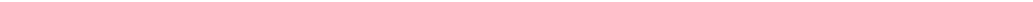
(see fi gure on previous page) Fig. 3 PNO1 inhibits cell apoptosis by promoting autophagy. A Autophagy was evaluated using TEM in Hep3B sh-Ctrl and sh-PNO1 cells. The arrows indicate autophagosomes or autolysosomes. Scale bar = 5 μ m (upper) or Scale bar = 1 μ m (lower). B Hep3B sh-Ctrl, Hep3B sh-PNO1, HLE Vector, and HLE PNO1 cells were immunostained with antibodies against LC3B. Scale bar: 50 μ m. C Western blotting analysis of autophagy-related protein level. D , E Quanti fi cation of relative protein expression. F – H Hep3B sh-Ctrl, Hep3B sh-PNO1, HLE Vector, and HLE PNO1 cells transfected with GFP-mRFP-LC3 lentivirus. Hep3B sh-PNO1 and HLE PNO1 cells were pretreated with rapamycin and 3-MA, respectively. Images were then acquired by fl uorescence microscopy ( F ) and the average number of yellow dots (autophagosomes) or red-only dots (autolysosomes) in the merged images per cell was quanti fi ed ( G , H ). Scale bar: 5 μ m. I – K Apoptotic rate was measured using annexin V/PI double staining in cells as in ( F ). L , M CCK-8 assay assessed the viability of cells as in ( F ). N Western blotting analysis of apoptosis and autophagy-related protein levels in cells as in ( F ). O , P Quanti fi cation of relative protein expression. Data were presented as mean ± SEM. n = 3 – 4. * p < 0.05, ** p < 0.01, *** p <